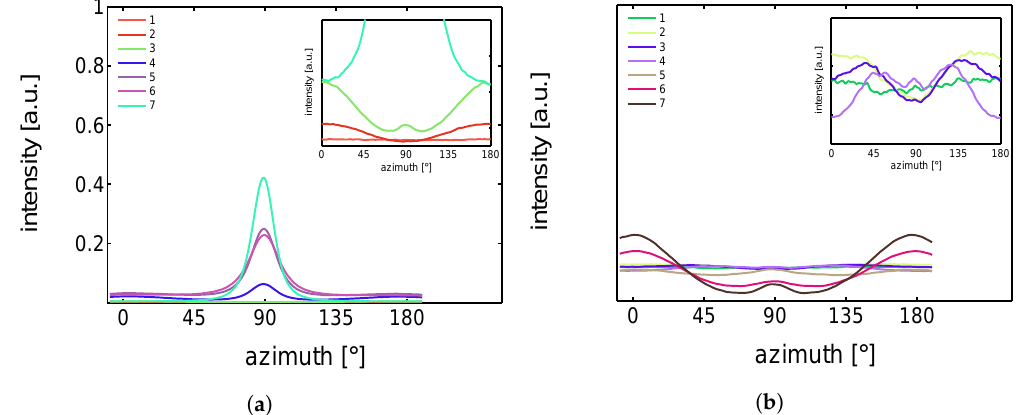
Figure 22. Azimuthal intensity of the lamellar scattering at various strains of α -iPP. ( a ) uni-axial stretching at 25 ◦ C and ( b ) 110 ◦ C. The numbers in the legend correspond to the 2D patterns in Figure